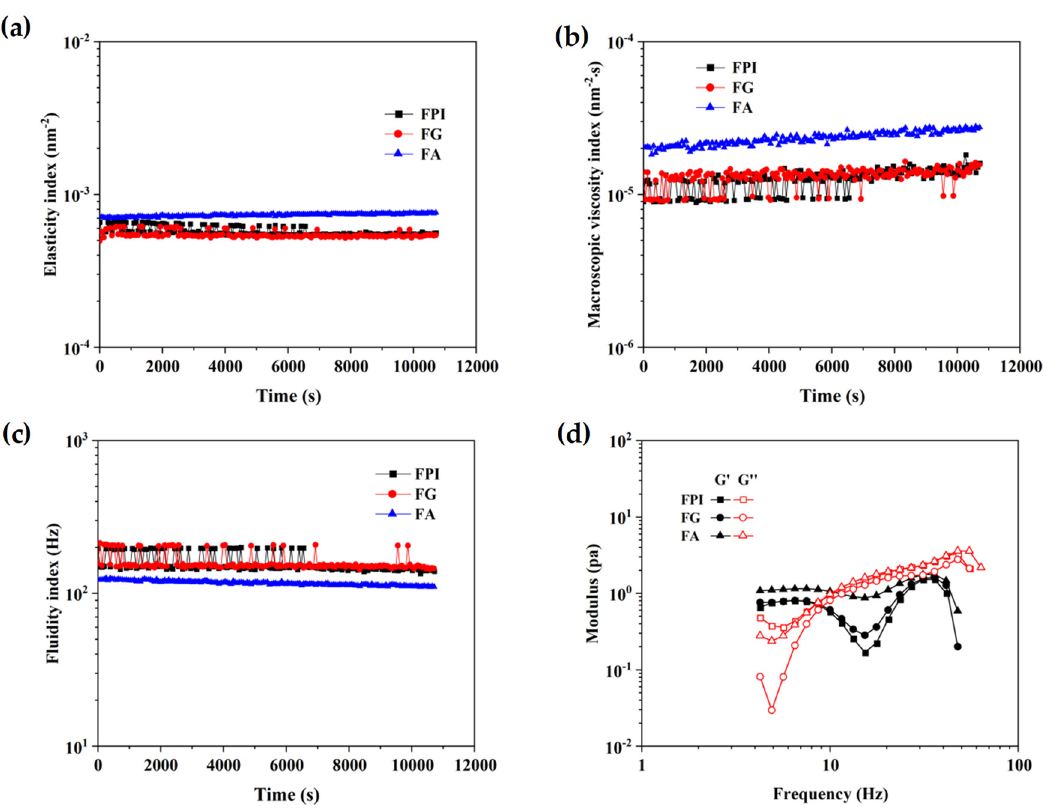
Figure 5. The microrheological properties of emulsions constructed by FPI, FG, and FA. ( a ): the elasticity index; ( b ): the macroscopic viscosity index; ( c ): the fluidity index; ( d ): the storage modulus G ′ and loss modulus G ″ . FPI: flaxseed protein isolate; FG: flaxseed globulin; FA: flaxseed albumin.